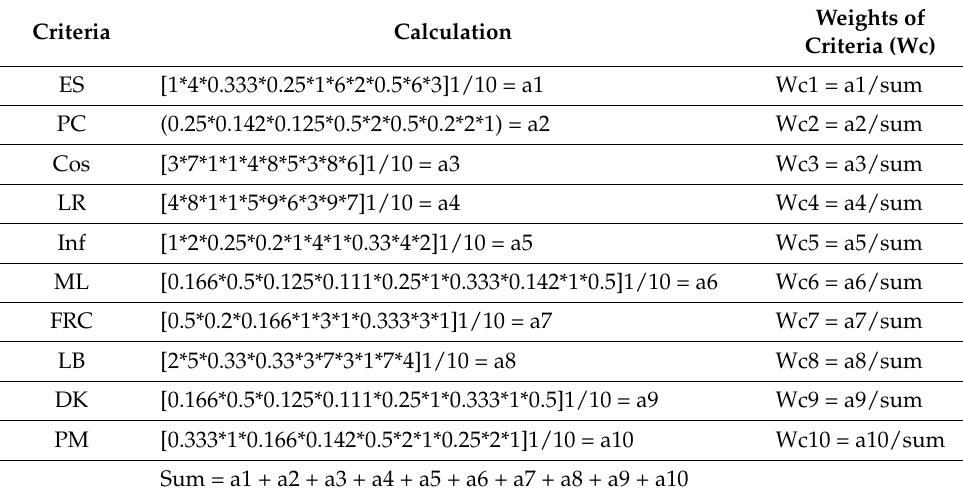
Table 7. Calculation of criteria’s